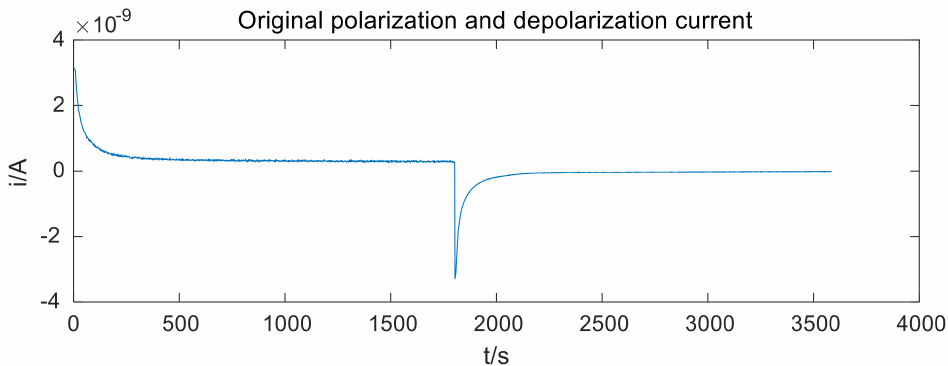
Figure 2. The PDC curve.